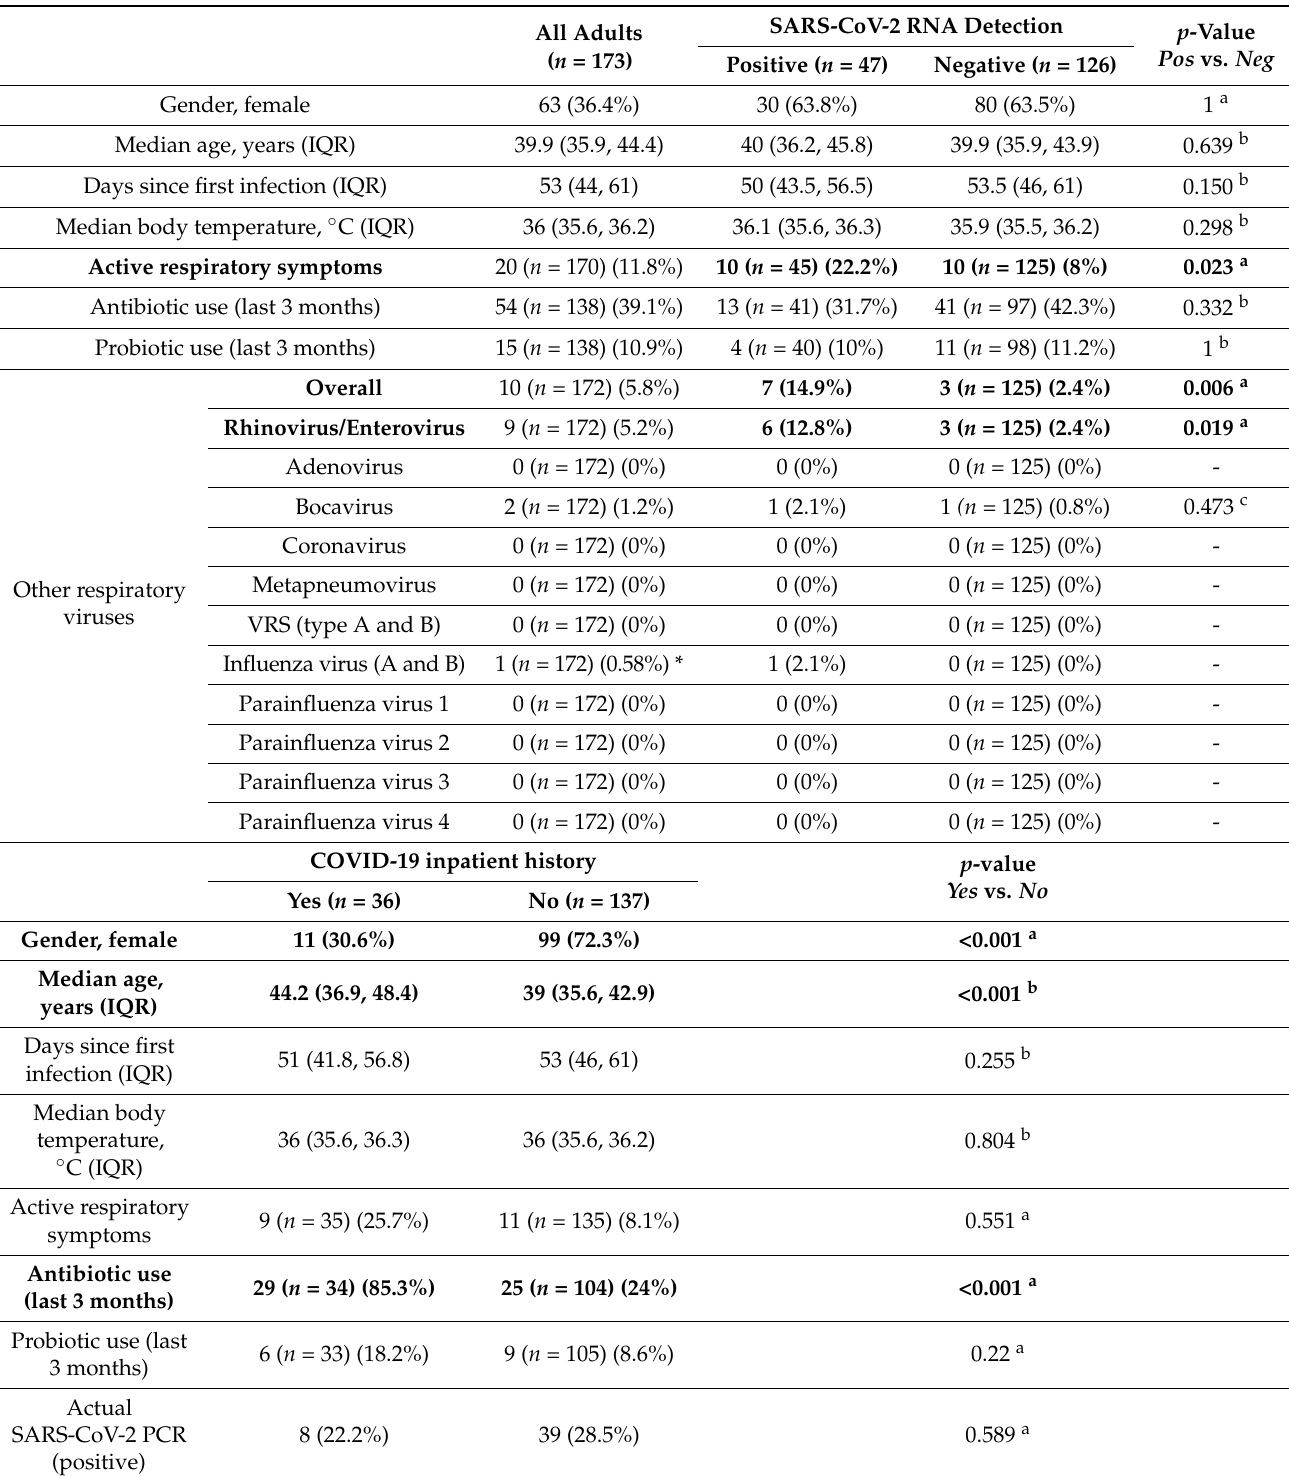
Table 2. Demographics of the adult population by SARS-CoV-2 RNA detection by RT-PCR and COVID-19